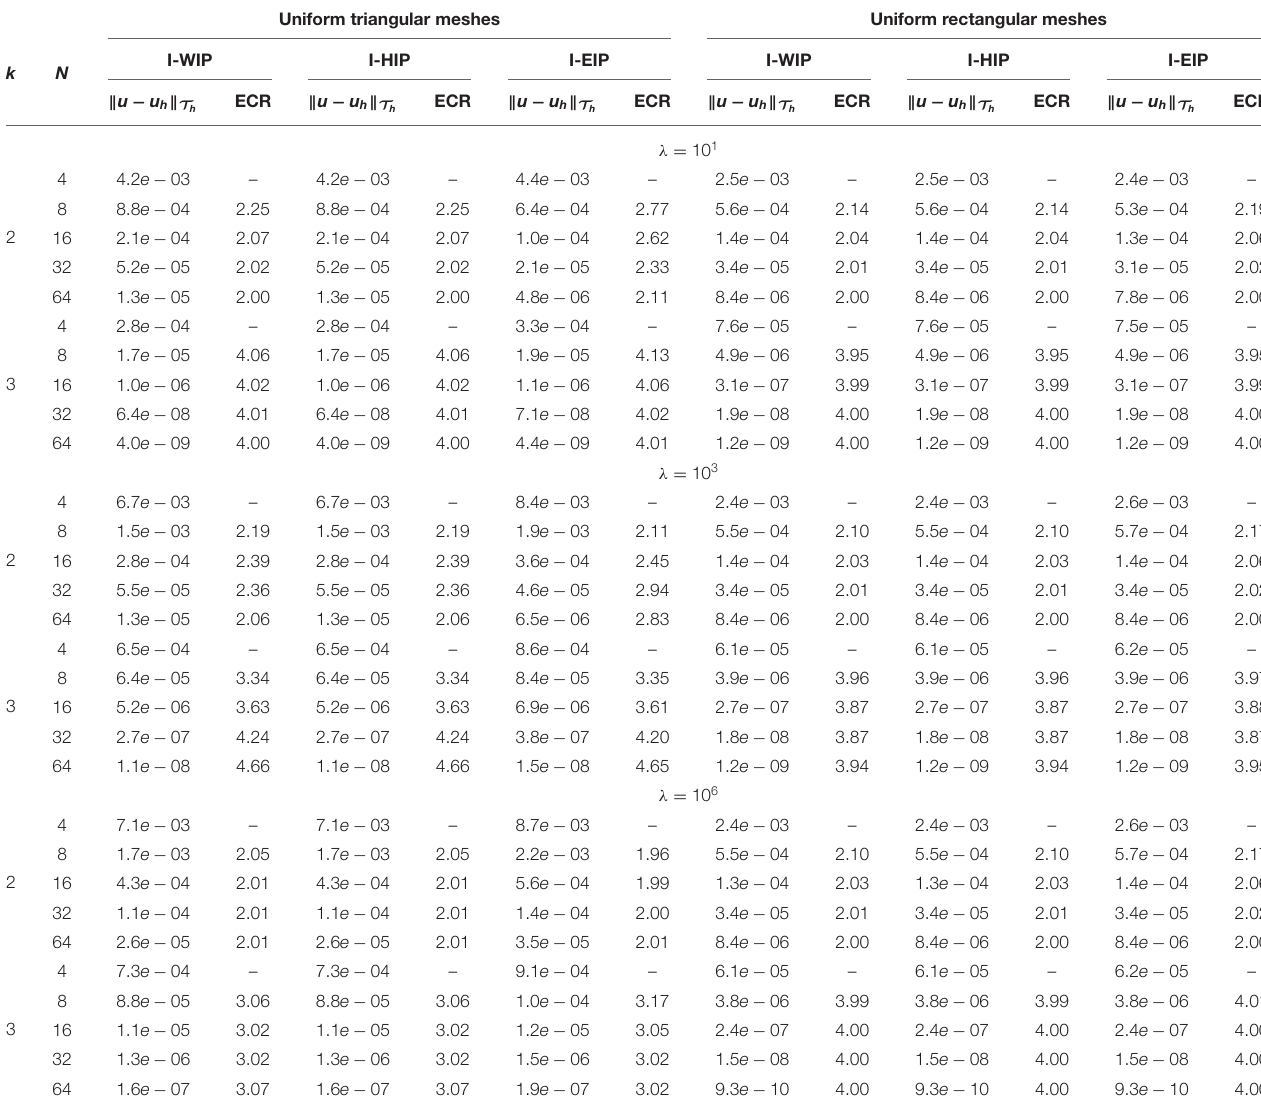
TABLE 3 | Heterogeneous and anisotropic case. Uniform triangular meshes Uniform rectangular